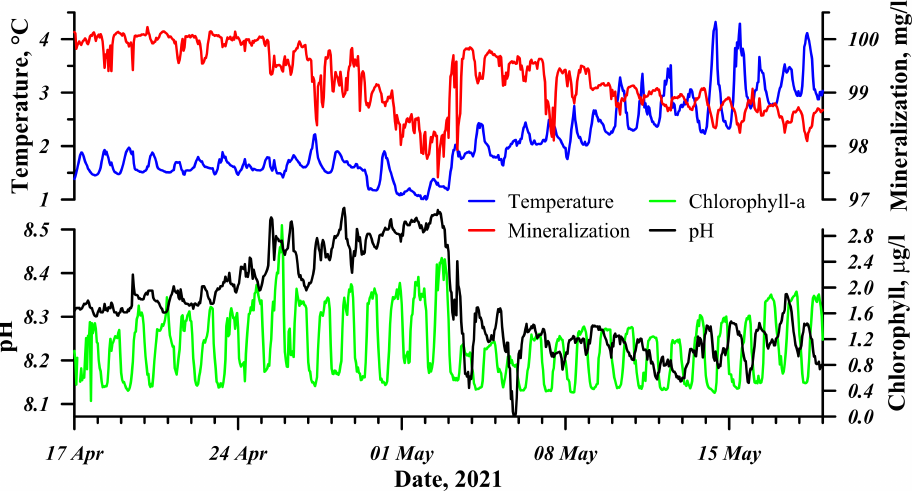
Figure 7. Time dynamics of various parameters from April to May